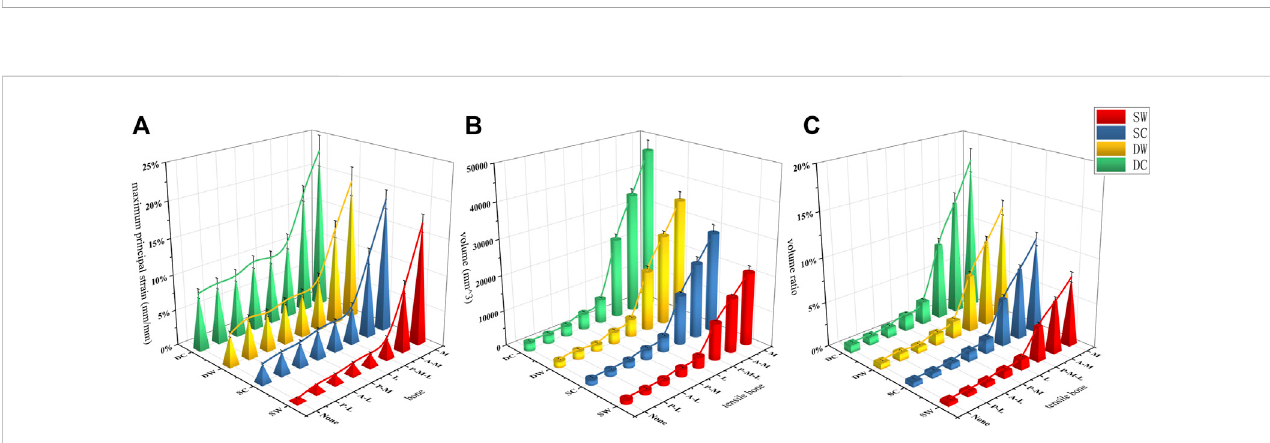
FIGURE 8 The maximum principal strain, the risky tensile bone volume, and the volume ratio curves of the bone models were exhibited in (A – C) ,